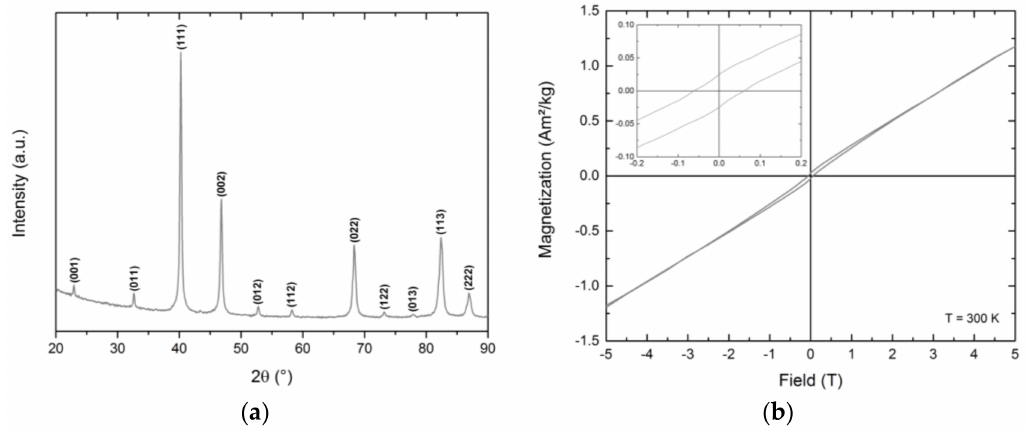
Figure A4. The diffraction pattern of BnOBn-FePt nanoparticles annealed at 800 ◦ C for 5 h reveal the predominantly L1 2 phase of FePt 3 ( a ) and the magnetic characterization para- combined with ferromagnetism ( b